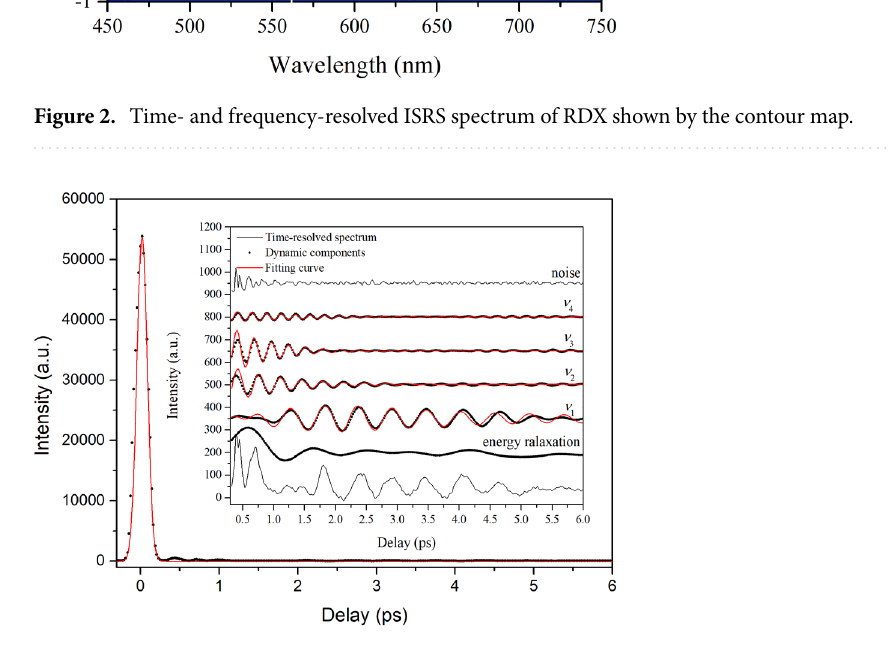
Figure 3. Time-resolved ISRS spectrum at 560 nm. (Inset) Oscillation structures in the time-resolved ISRS spectrum. The vibrational modes are named ν n (n = 1, 2, 3,